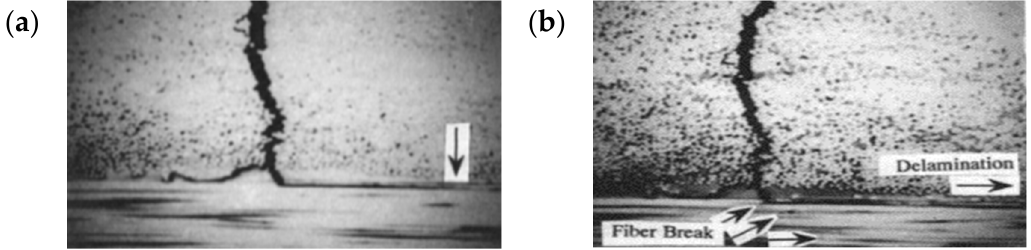
Figure 11. Transverse crack propagation in the LCF regime [29]: ( a ) transverse crack and stratification and ( b ) fiber fracture.